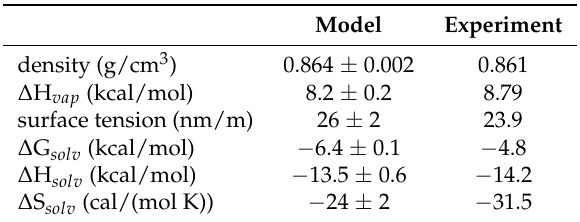
Table 3. Properties of liquid 1,2-dimethoxyethane and the aqueous solvation thermodynamics values of 1,2-dimethoxyethane, at 298